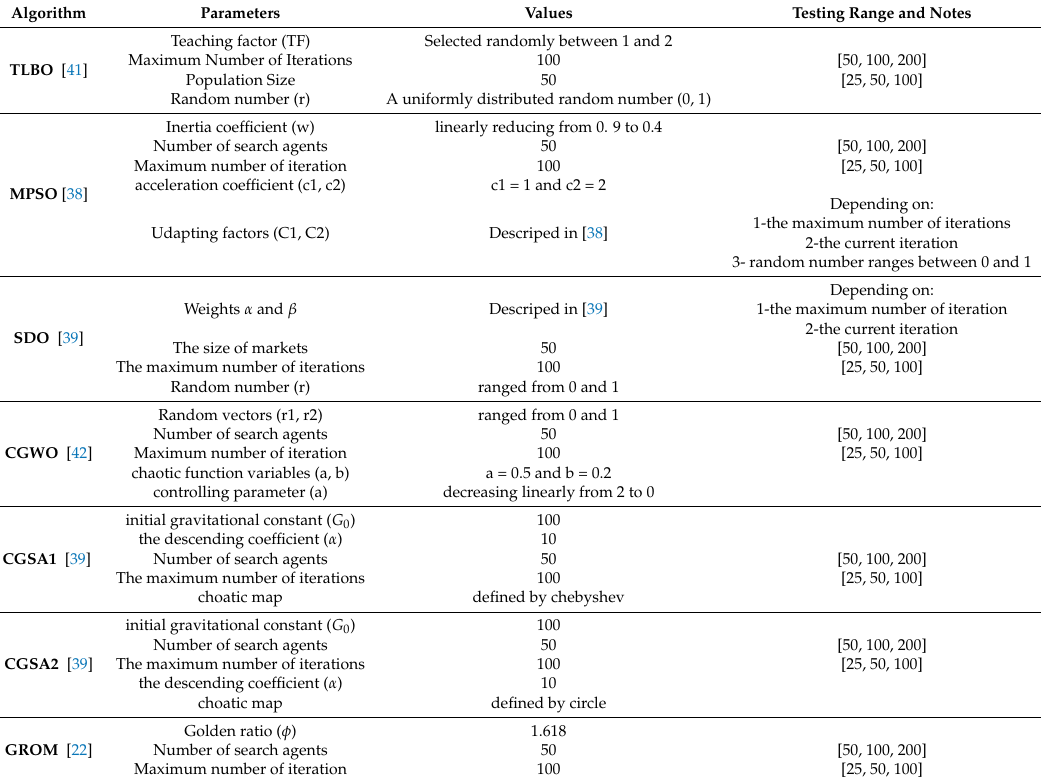
Table 12. Parameters and testing ranges of optimization